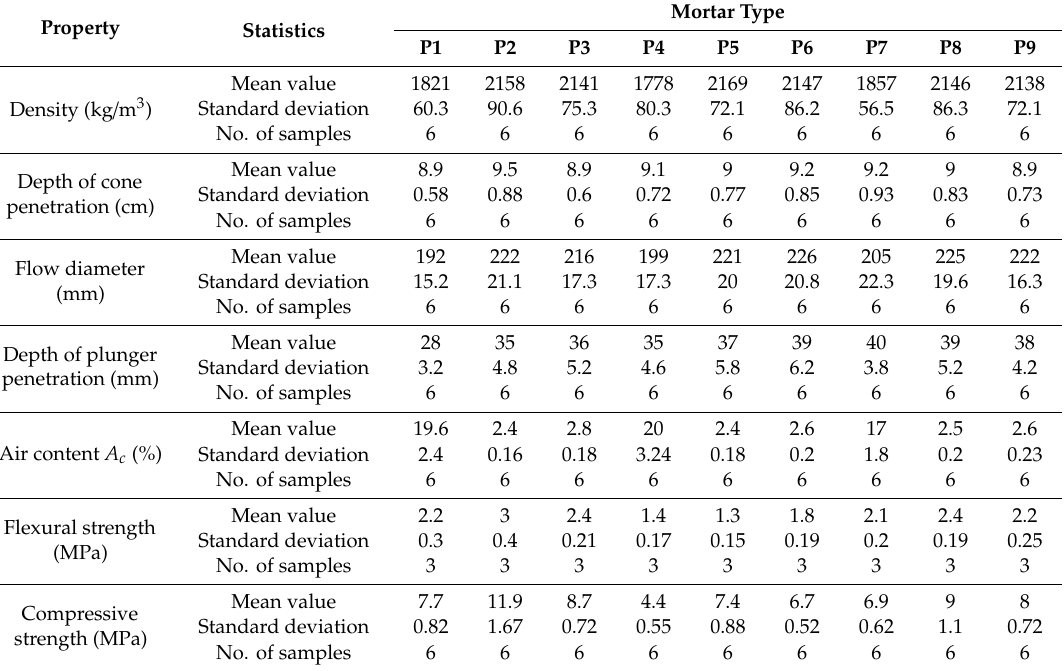
Table 5. Results of tests of the influence of cement type on properties of plaster.